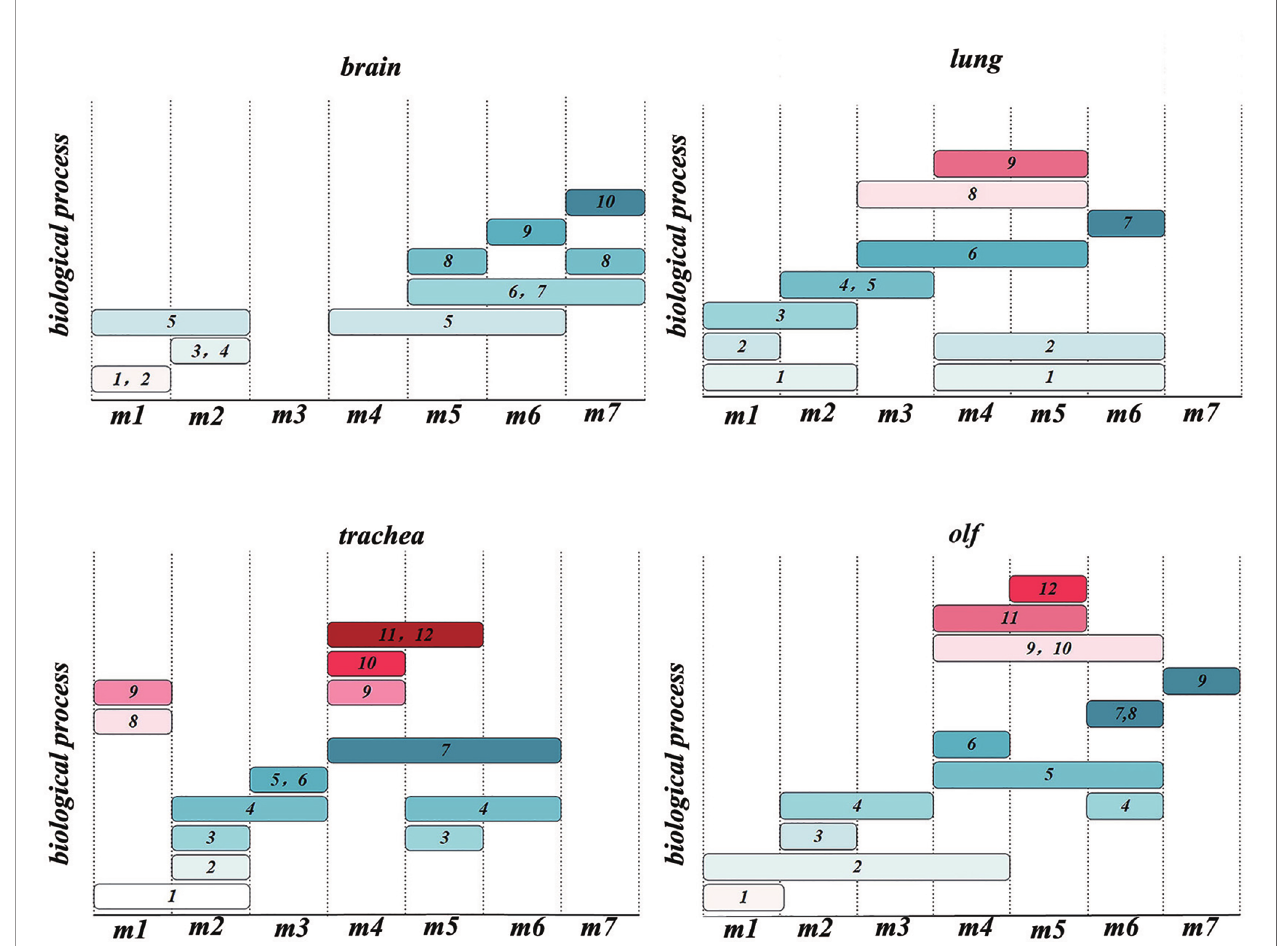
FIGURE 5 | Time-order Gene Ontology (GO) enrichment analysis results of different organs 1. nucleic acid metabolic process; 2. cell cycle; 3. nervous system process; 4. signal transduction; 5. cellular component organization; 6. energy derivation by oxidation of organic compounds; 7. ATP metabolic process; 8. nucleoside phosphate metabolic process; 9. protein metabolic process; 10. ion transmembrane transport; 11. regulation of locomotion; 12. vasculature development; 13. secretion by cell; 14. lipid metabolic process; 15. myeloid leukocyte activation; 16. myeloid leukocyte-mediated immunity; 17. macromolecule localization; 18. protein catabolic process; 19. cellular metabolic process; 20. nucleotide metabolic process; 21. muscle system process; 22. response to stimulus; 23. immune response-regulating signaling pathway; 24. regulation of innate immune response; 25. antigen processing and presentation; 26. head development; 27. small molecule metabolic process; 28. vesicle-mediated transport; 29. regulation of body fl uid